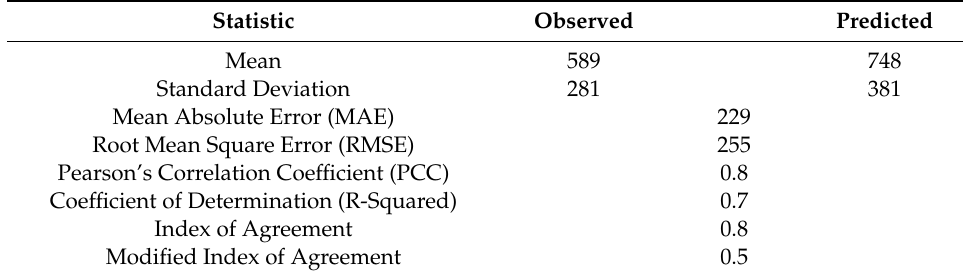
Table 6. Statistics for observed and predicted annual mean suspended sediment